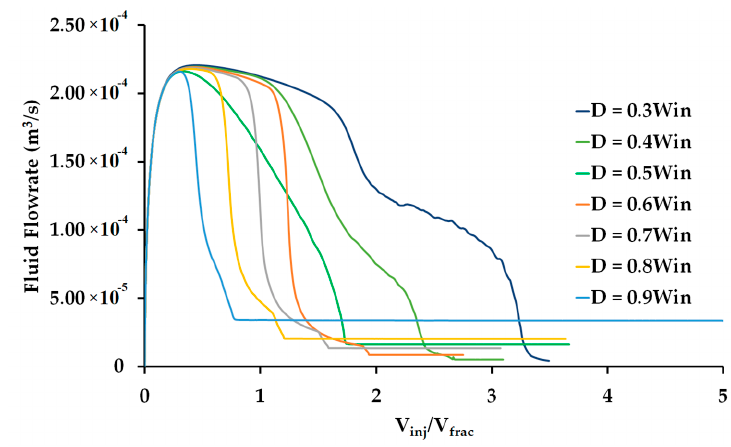
Figure 7. Flowrate at fracture outlet of seven different particle diameters.